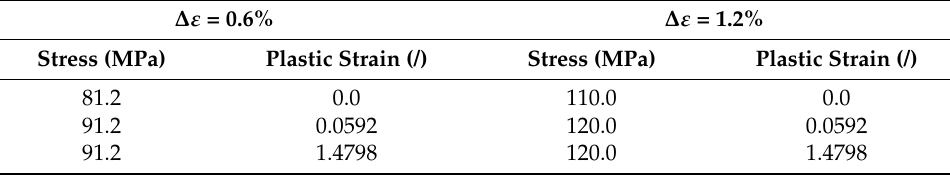
Table 2. Isotropic hardening properties, using the ABAQUS “*Cyclic Hardening” option. ∆ ε =